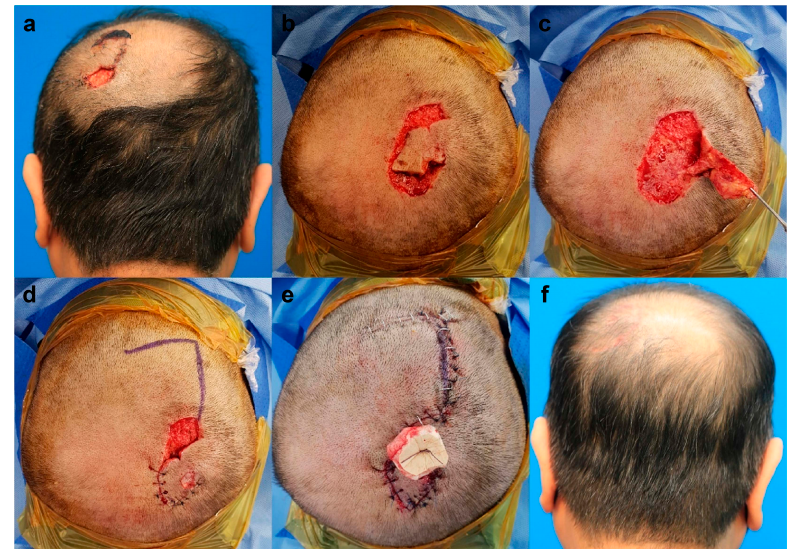
Figure 3. Clinical photographs of case 2. ( a ) Skin necrosis and defect in the vertex scalp after skin avulsion injury. ( b , c ) After debridement, the intact midportion of the original avulsion skin flap was used as a rotational flap for the anterior defect (2 cm × 3.5 cm) coverage. ( d ) Design of a hemi-key- stone perforator island flap (KPIF) (6 cm × 7 cm) for the posterior final defect (3 cm × 4 cm) coverage